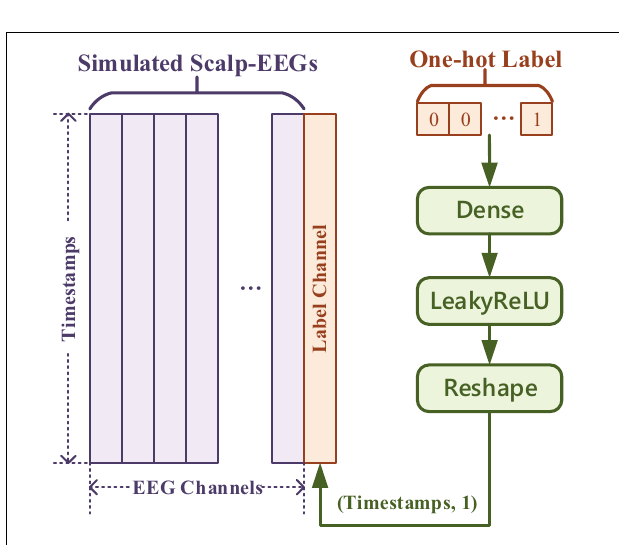
FIGURE 8 | The label input in “simulated EEGs conversion GAN.”